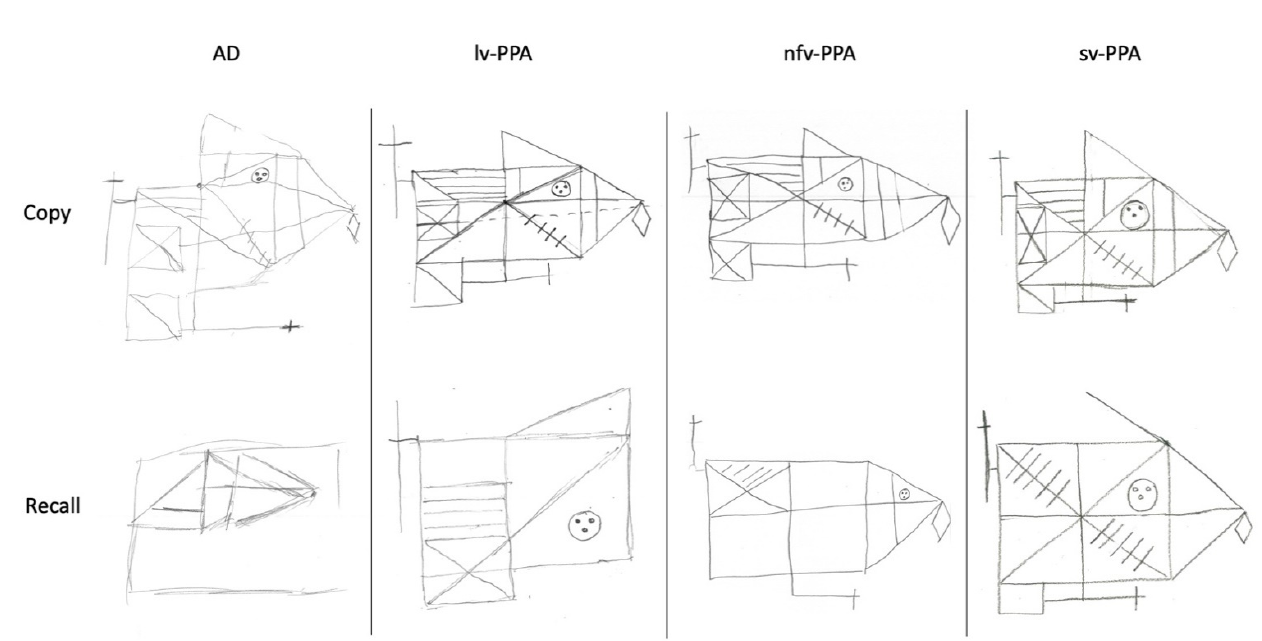
Figure 4. Rey Complex Figure copy and 3-minute recall. Copy performance was very impaired for the AD patient, borderline-impaired for the lv-PPA and nfv-PPA patients, and within normal limits for the sv-PPA patient. Three-minute recall performance was very impaired for the AD patient, borderline-impaired for the lv-PPA patient, and within normal limits for the nfv-PPA and sv-PPA patients.